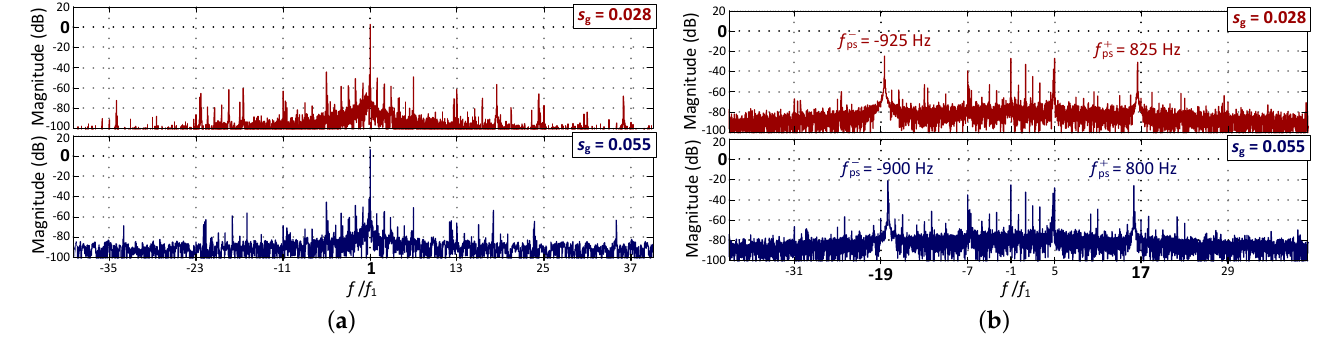
Figure 22. Complex spectrum of stator current for six-phase IM with asymmetrical SWA, one pole pair and 18 rotor slots [202]. In the label of the horizontal axis, f represents any frequency and f 1 the fundamental frequency. ( a ) α 1 - β 1 plane. ( b ) α 5 - β 5 (i.e., x - y )